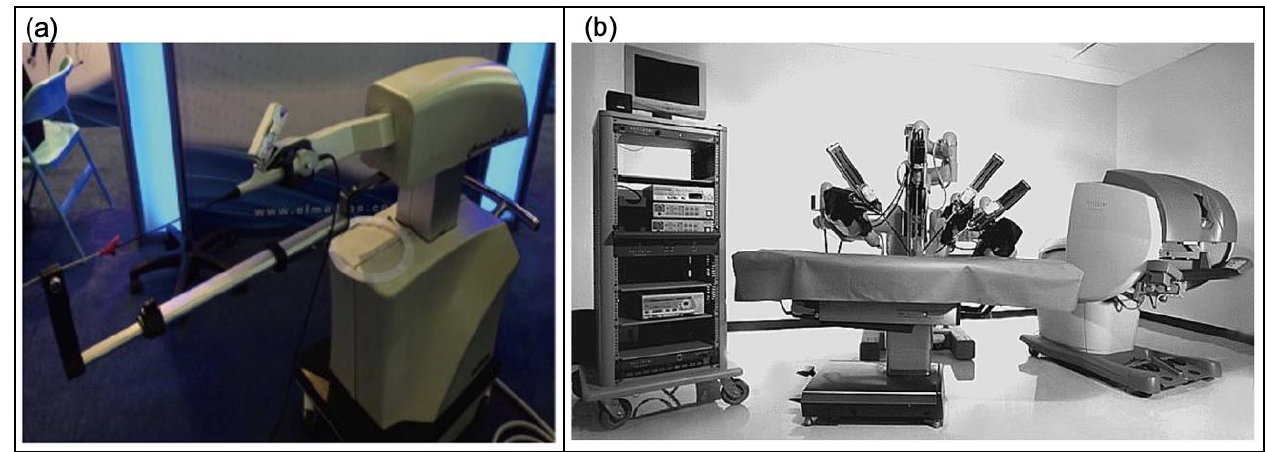
Figure 13. Robotic surgery instruments. ( a ) The robotic flexible ureteroscopy machine [54]. ( b ) The da Vinci surgical system. From left to right: image processing stack, a patient-side cart containing robotic arms and the surgeon’s console [138]. Copyright 2007, IEEE.